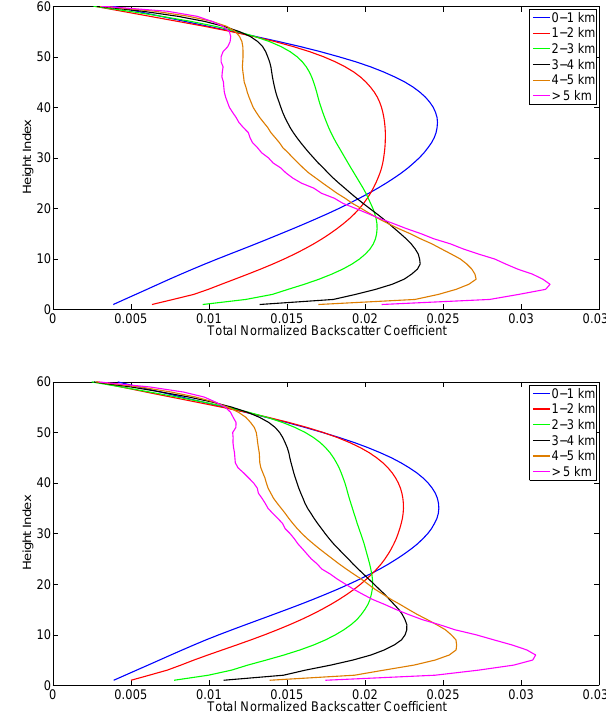
Fig. 5. Cirrus clouds mean backscatter profiles for multiple thickness intervals. Data refer to nighttime. In the upper panel the backscatter profiles of midlatitude clouds are plotted as functions of height indexes. The lower panel shows profiles for the tropical case.